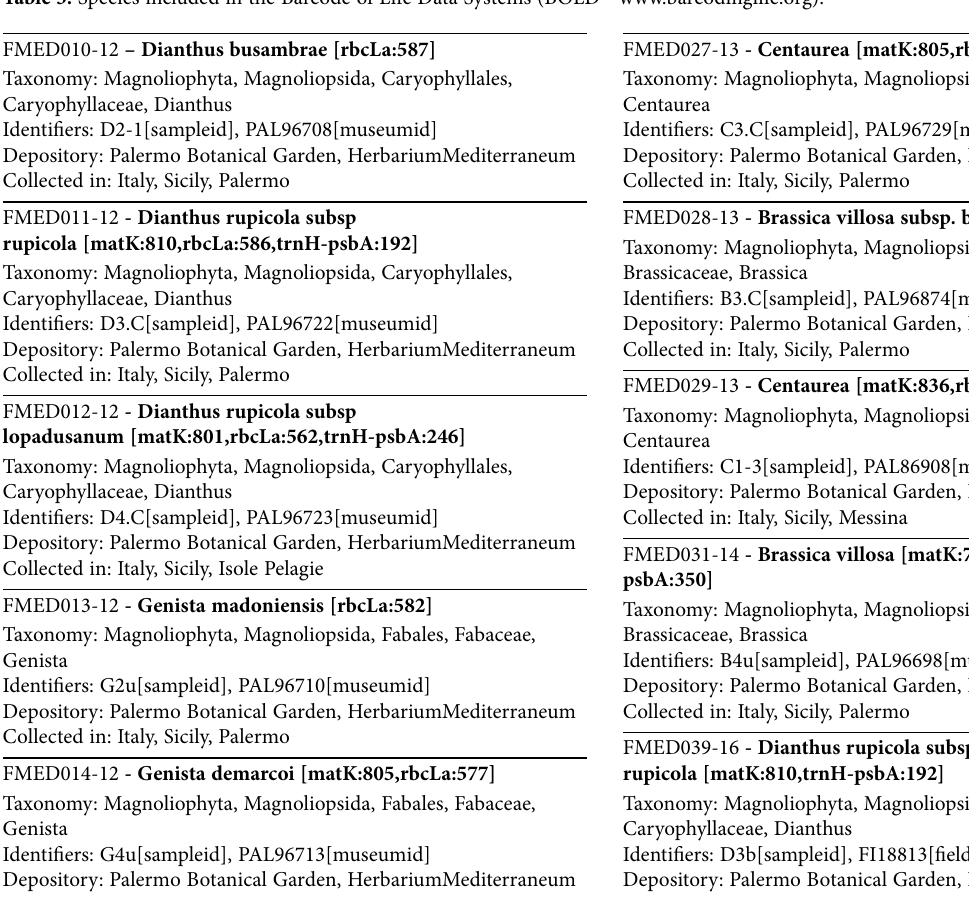
Table 5. Species included in the Barcode of Life Data Systems (BOLD -